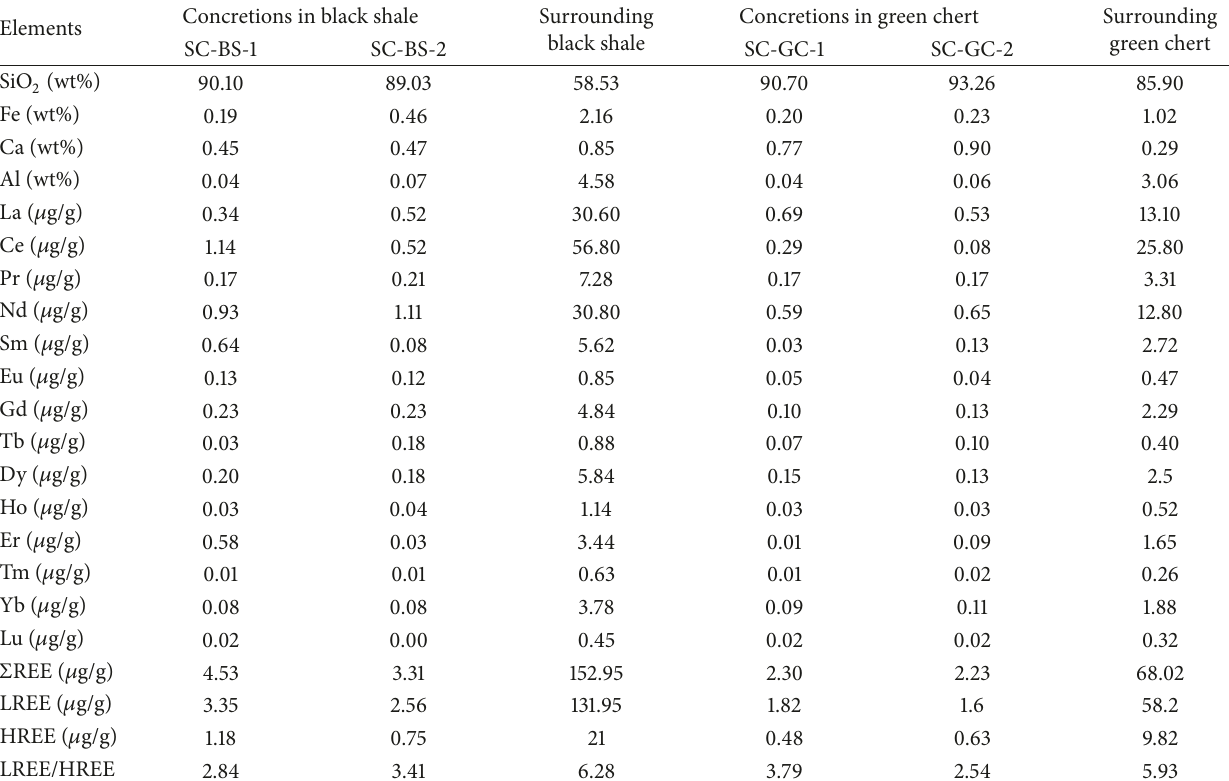
Figure 2: Selected ellipsoidal-type concretion (a) and the reconstructed three-dimensional imaging with resolution of 27 𝜇 m (b–d). Table 1: Major and rare earth elements contents in the concretion shells and surrounding